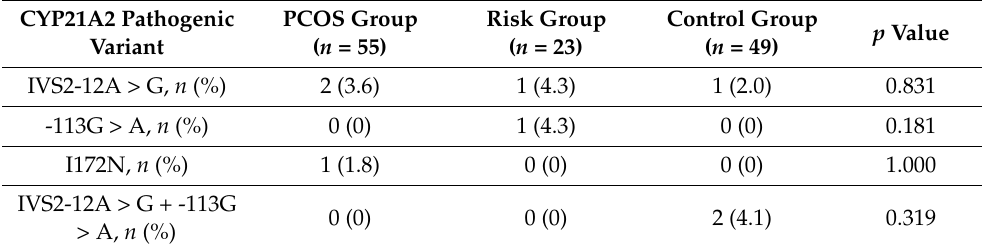
Table 2. Frequency of identified CYP21A2 alleles in all study groups.